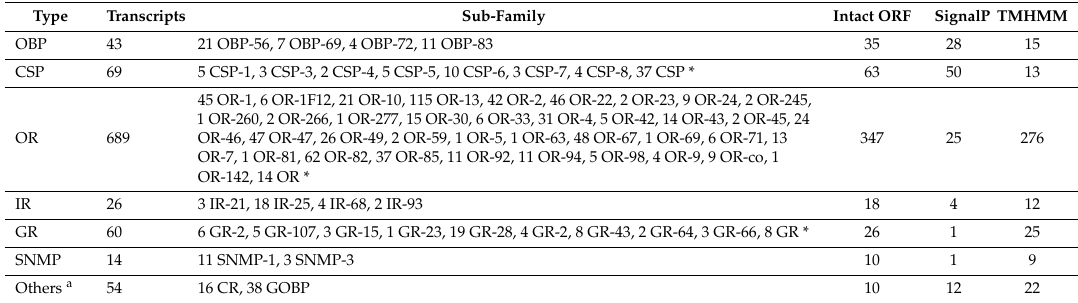
Table 2. Olfactory genes identified in the Ashmead